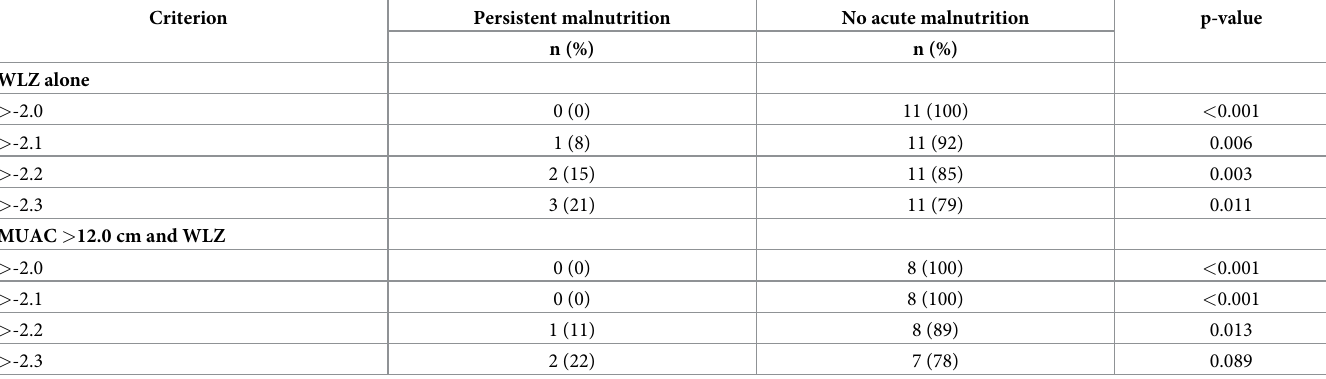
Table 3. Persistent malnutrition rates at three months compared to no acute malnutrition based on anthropometry at hospital